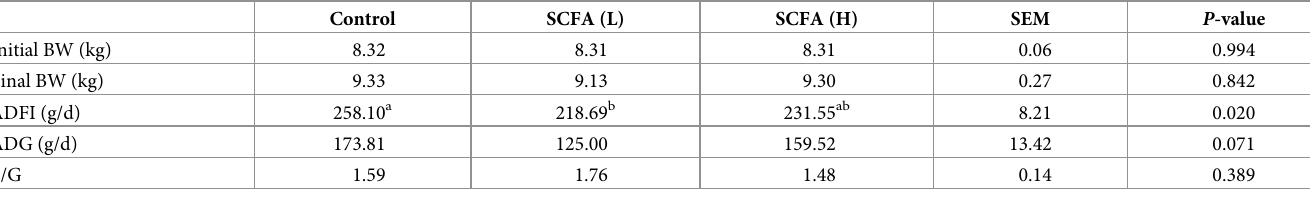
Table 3. Effects of SCFAs on the growth performance over the experimental period of weaned pigs. Control